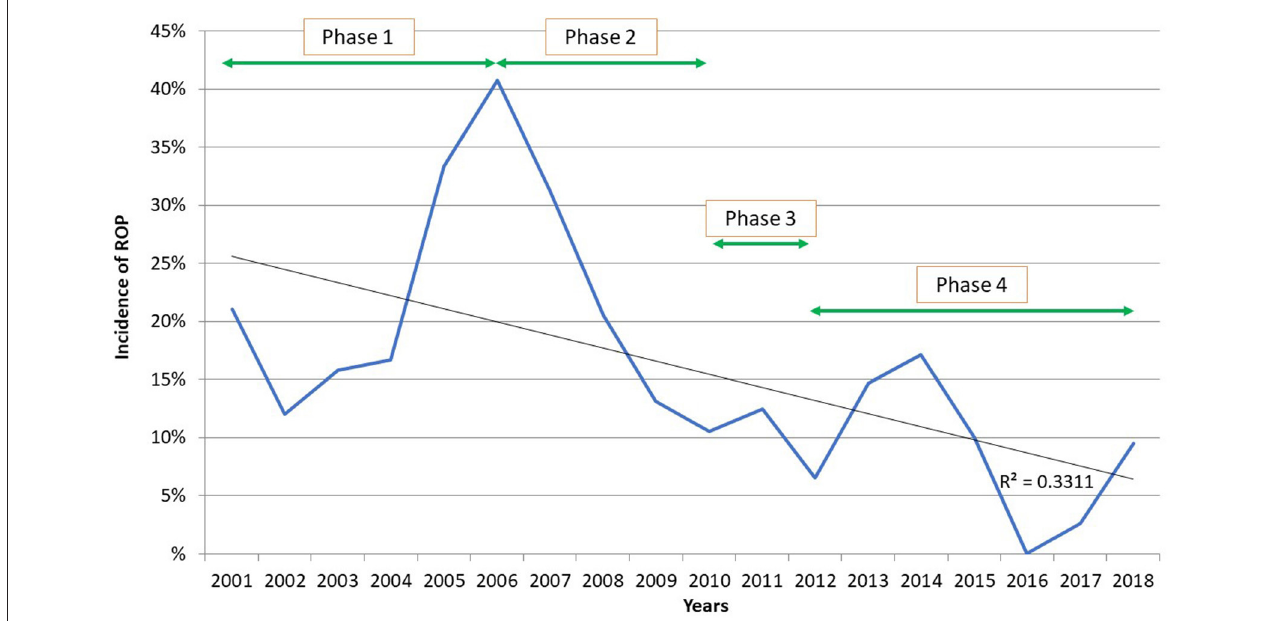
FIGURE 1 | Incidence of ROP in pre-term newborns weighing < 1,500g born in our hospital